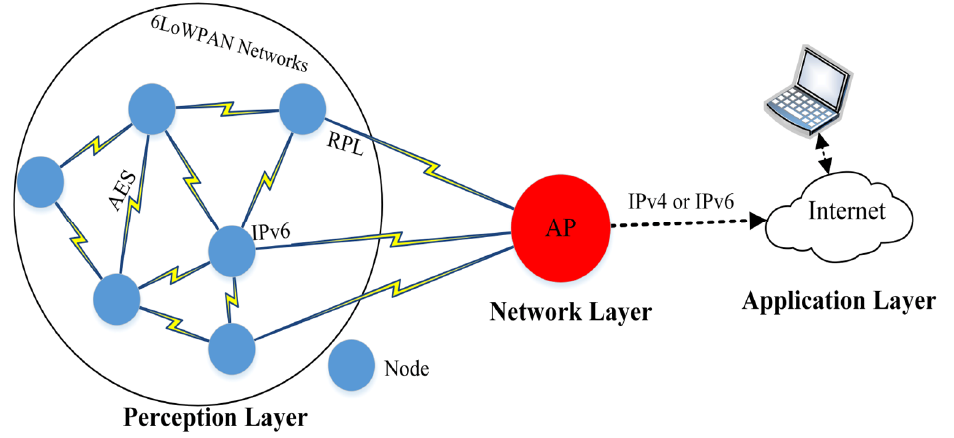
Figure 1. 6LoWPAN infrastructure.